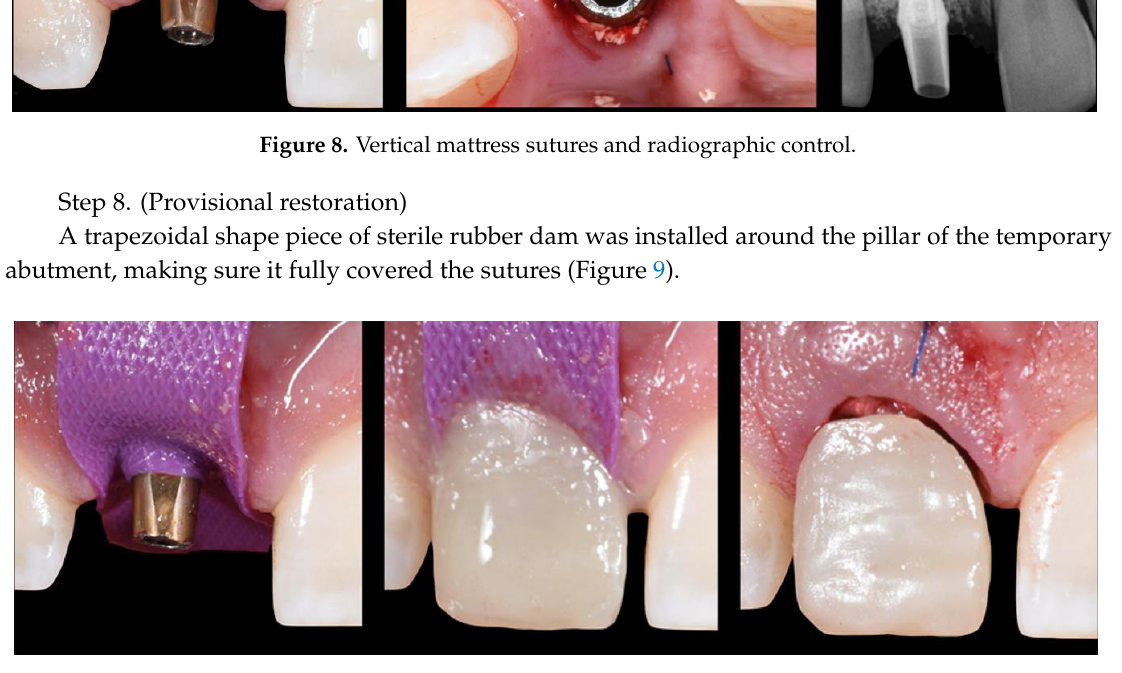
Figure 9. Rubber dam adaptation and fabrication of the first provisional restoration so that its cervical portion is limited supra-gingivally after connection.